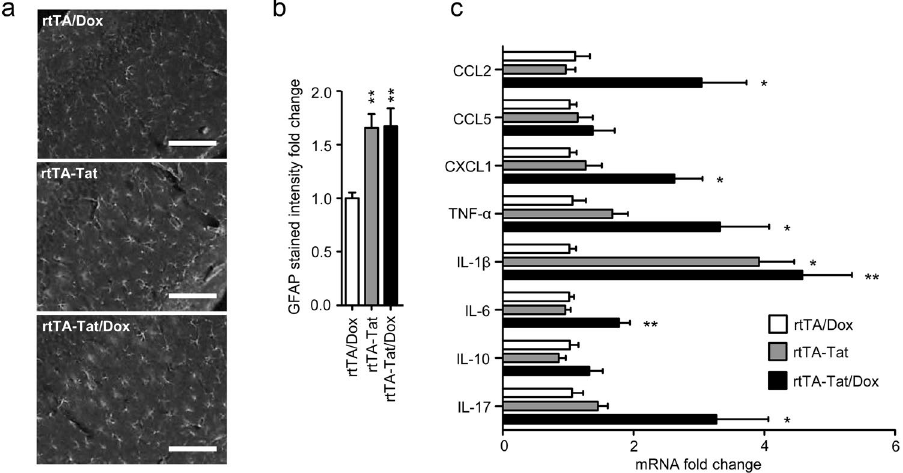
Figure 5. The increase in dentate gyrus volume is linked to an increase in reactive astrocytes in this brain region. ( a ) Representative images and ( b ) quantitative analysis of GFAP fluorescence from the dentate gyrus of 11–12 month old mice with the indicated genotypes. ( c ) qRT-PCR analysis showing expression of the indicated cytokines in hippocampus of 11–12 month old mice with the indicated genotype and treatment condition. Data are expressed as mean ± SEM for n = 6–7 per group. * p < 0.05, ** p < 0.01. ANOVA with Tukey post hoc